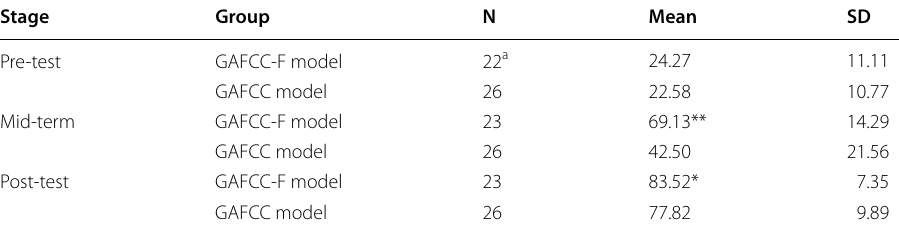
Table 1 Students’ learning performance in two gamification design model groups (learning performance: 100 full